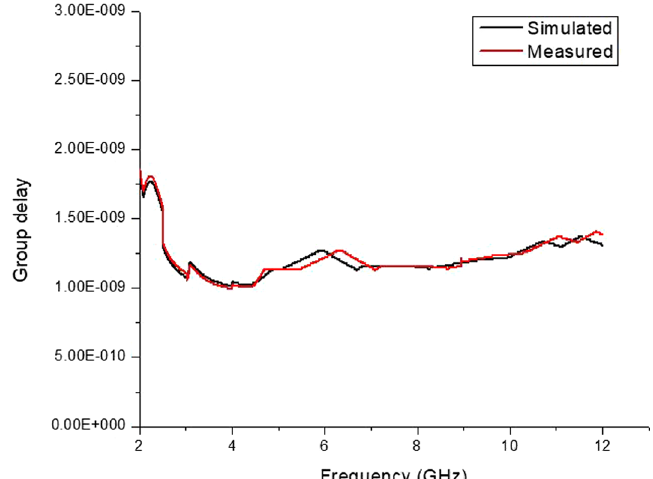
Fig. 8 Group delay of the proposed antenna